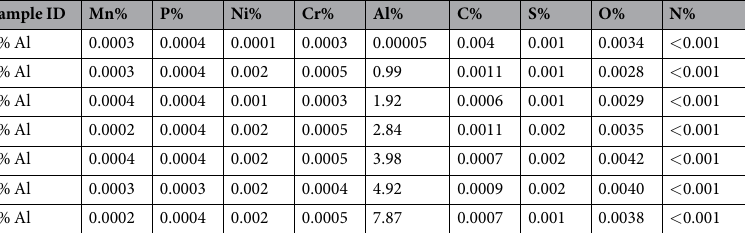
Table 1. The compositions of FeAl alloys used for the experiments in HT-CSLM presented in mass %. Compositions were measured by ICP.